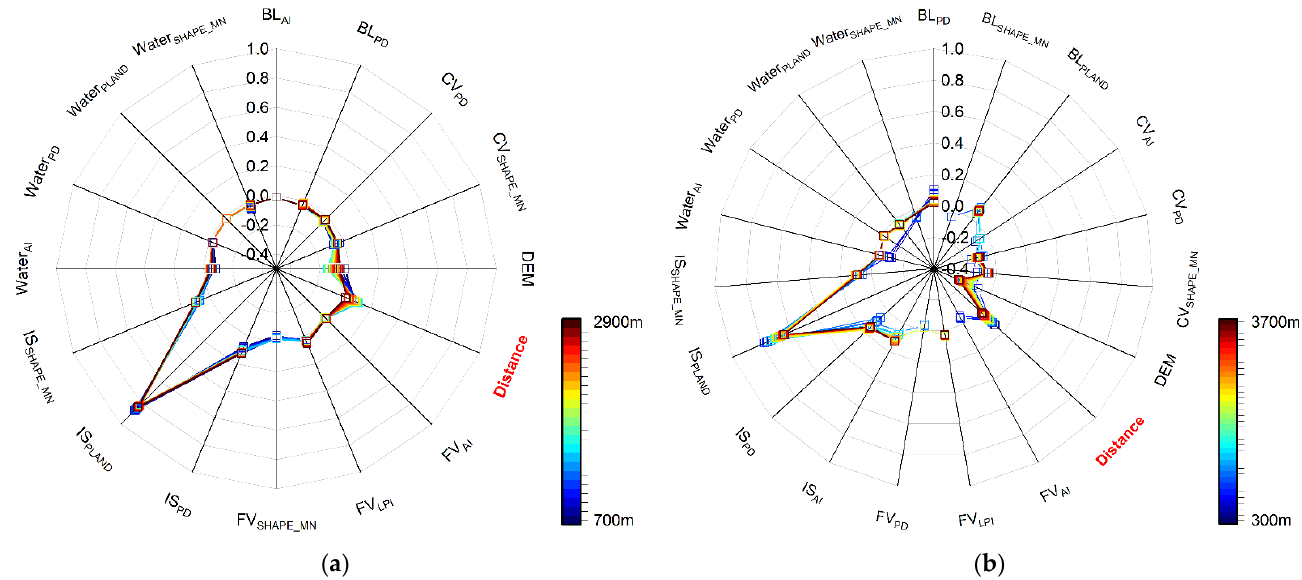
Figure 7. Radar diagrams showing the standardized coefficients of the multiple linear regressions for ( a ) West Lake and its neighboring areas, and ( b ) Xuanwu Lake and its neighboring areas. The significance levels of the coefficients are all less than 0.05 except for DEM (sig. = 0.058) from the 700 m model in Hangzhou, FV_AI (sig. = 0.067) from the 700 m model in Nanjing, FV_AI (sig. = 0.063) from the 900 m model in Nanjing, FV_PD (sig. = 0.062) from the 1200 m model in Nanjing and BL_PD (sig. = 0.050) from the 1400 m model in Nanjing.